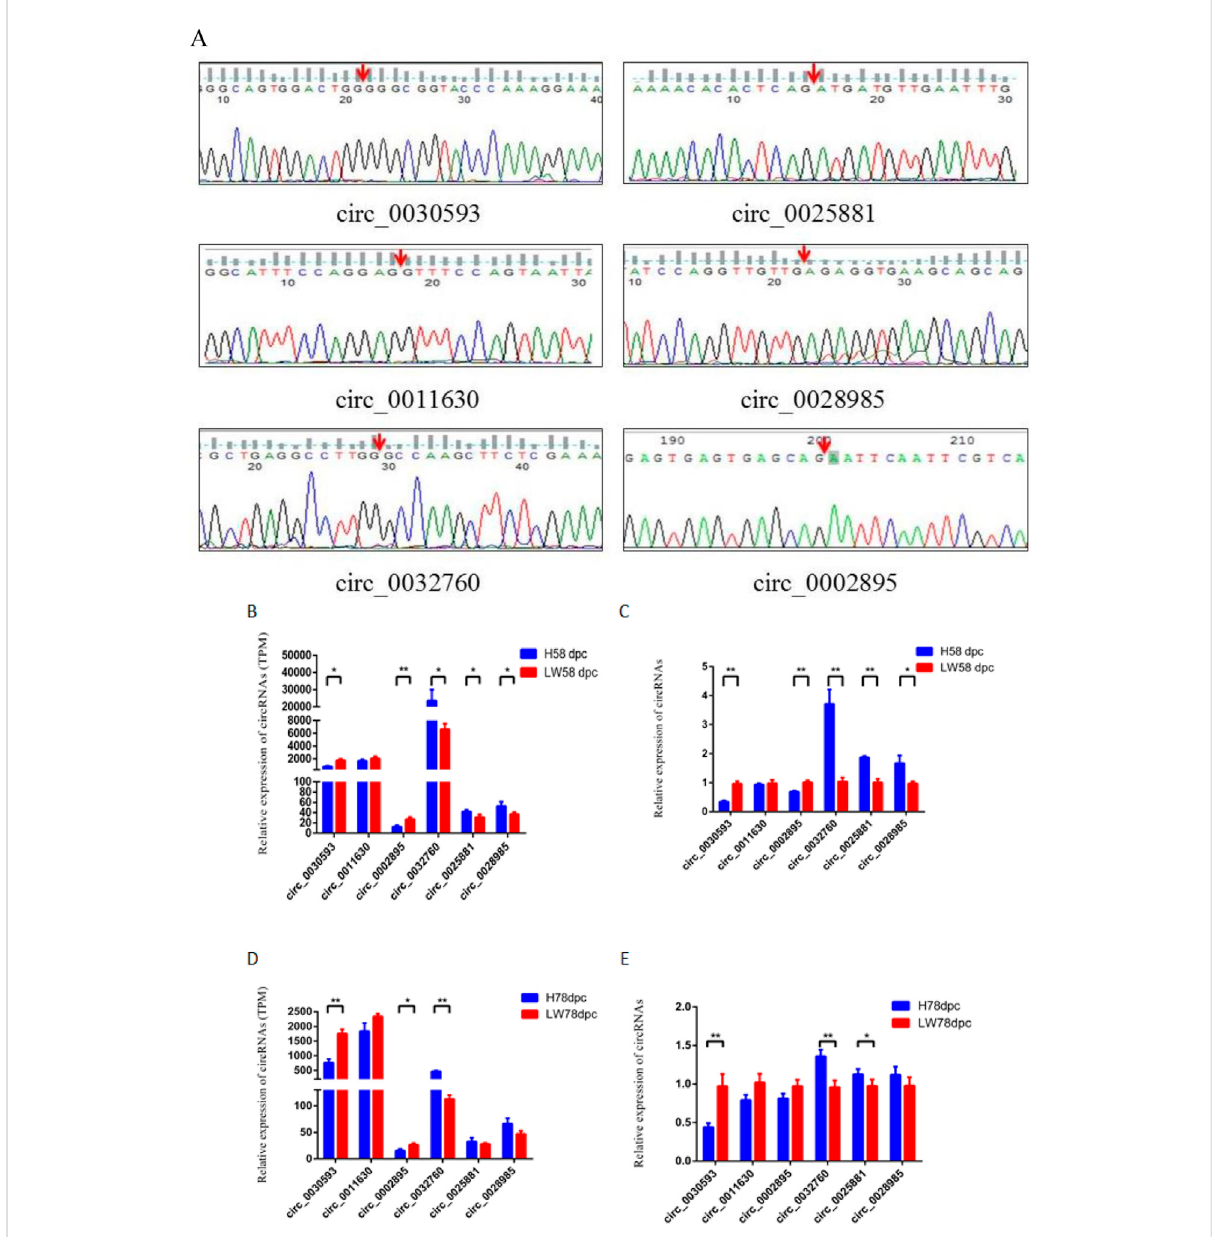
FIGURE 6 Validation of differently expressed circRNAs (A) The back-splicing junction sequence of circRNAs by sanger sequencing using the convergent primers. RNA sequecing (B,D) results and RT-qPCR results (C,E) of six differently expressed circRNAs between HN and LW at 58 dpc and 78